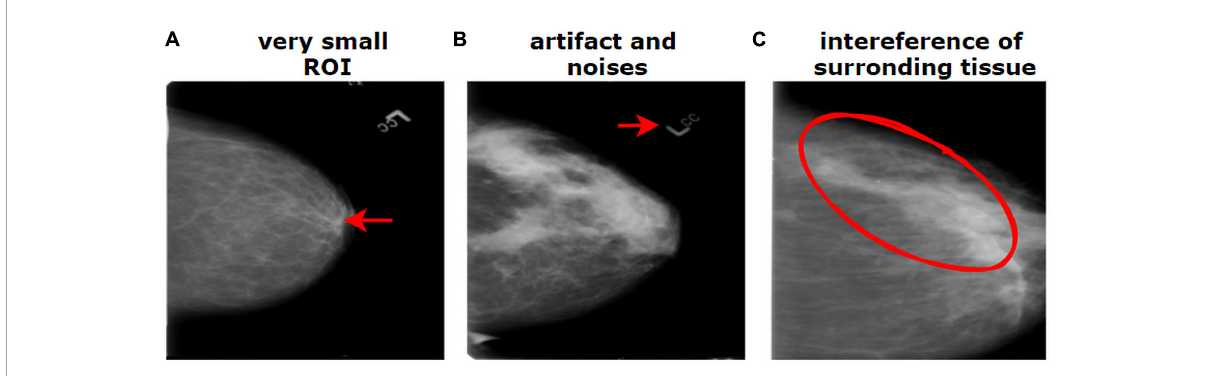
FIGURE1 Challenges of medical datasets showing breast mammography. (A) Very small ROI and (B) presence of artifacts. (B) The dissimilarity between the same class and (C) similarity between different classes.